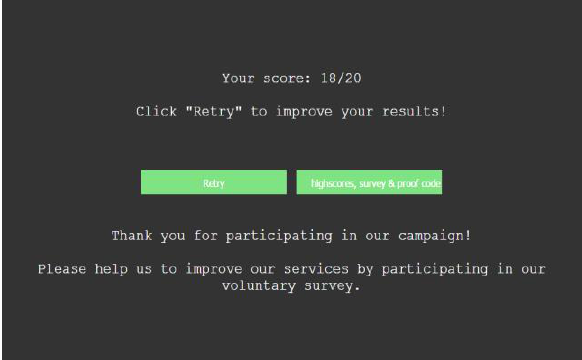
Figure 7 . After completion of the crowd job, the number of correctly labelled triangles is displayed.